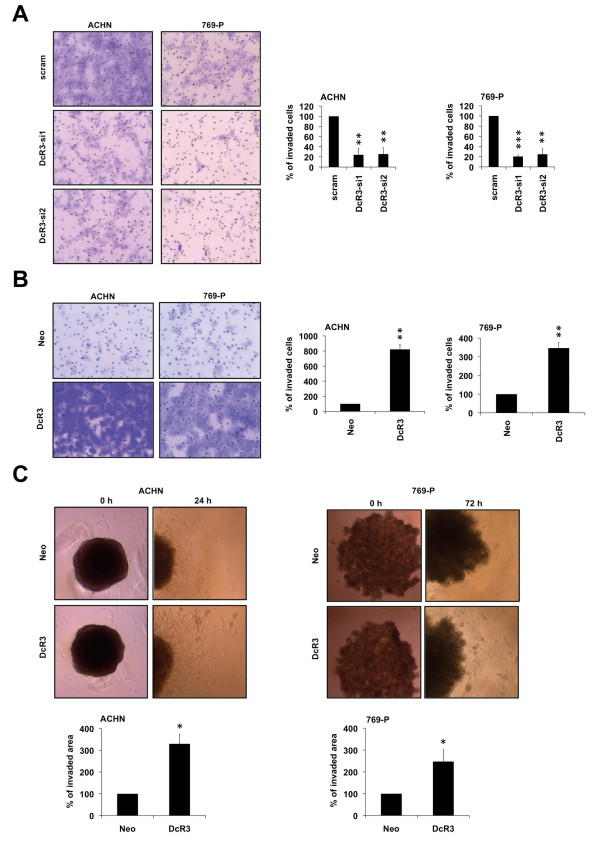
DcR3 promotes invasiveness in RCC cells. (A,B) Boyden chamber assay of ACHN and 769-P cells transfected with two different DcR3-specific siRNAs or a non-specific siRNA (scram) (A) or stably overexpressing DcR3 or an empty vector control (neo) (B). Bars indicate the percentage of cellular invasion in correlation to control cells. Invaded cells were counted in five representative fields (mean ± SEM; n=3, **p<0.01, ***p<0.001; T-test). Representative images are shown (magnification: 200×). (C) Spheroid assay of ACHN and 769-P cells stably overexpressing DcR3 or an empty control vector (neo). Bars indicate the percentage of cell invasion in relation to cells stably transfected with an empty control vector (mean ± SEM; n=3; *p<0.05, T-test). Representative images are shown (magnification: 40×).